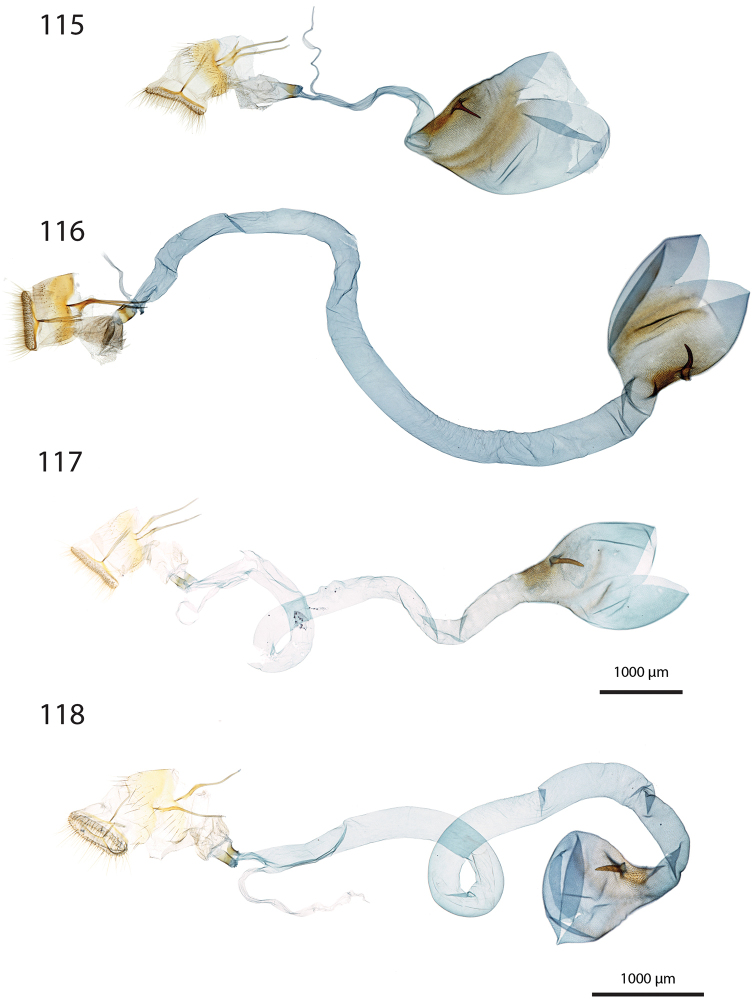
Female genitalia features of Hoploscopa. 115Hoploscopa
sumatrensis sp. nov., paratype, TL530 ♀ 116Hoploscopa
mallyi sp. nov., paratype, TL513 ♀ 117Hoploscopa
gracilis sp. nov., paratype, TL527 ♀ 118Hoploscopa
agtuuganonensis sp. nov., holotype, TL616 ♀.